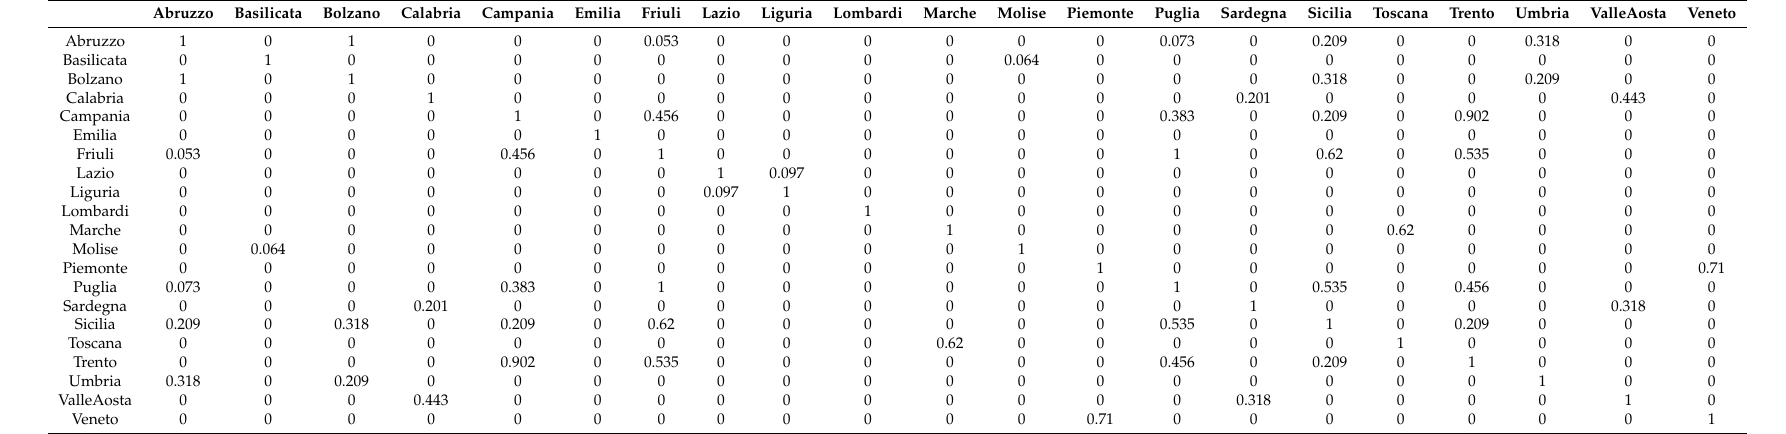
Table A54. Similarity values of Total Cases network in the fifth